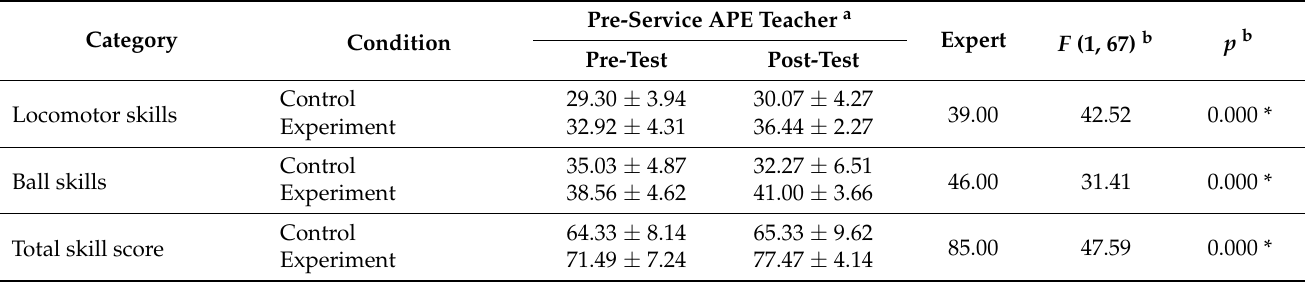
Table 2. Descriptive and statistical results in locomotor, ball skill, and total skill score between pre-service APE teachers and expert.